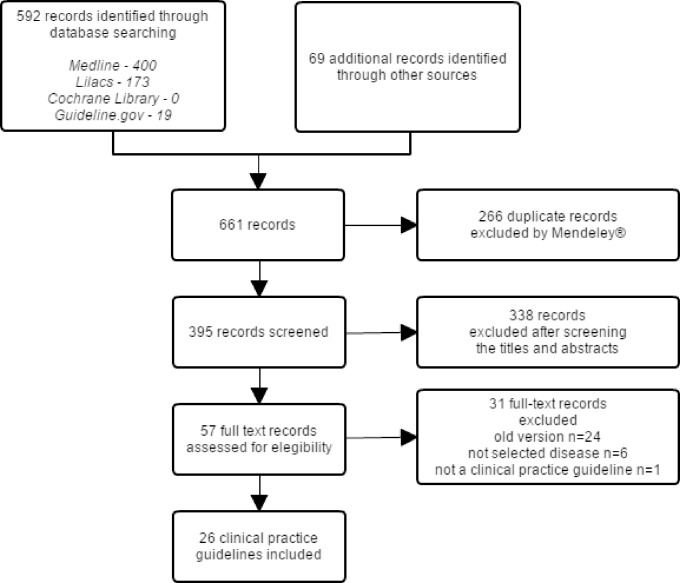
Flowchart of clinical practice guidelines selection.